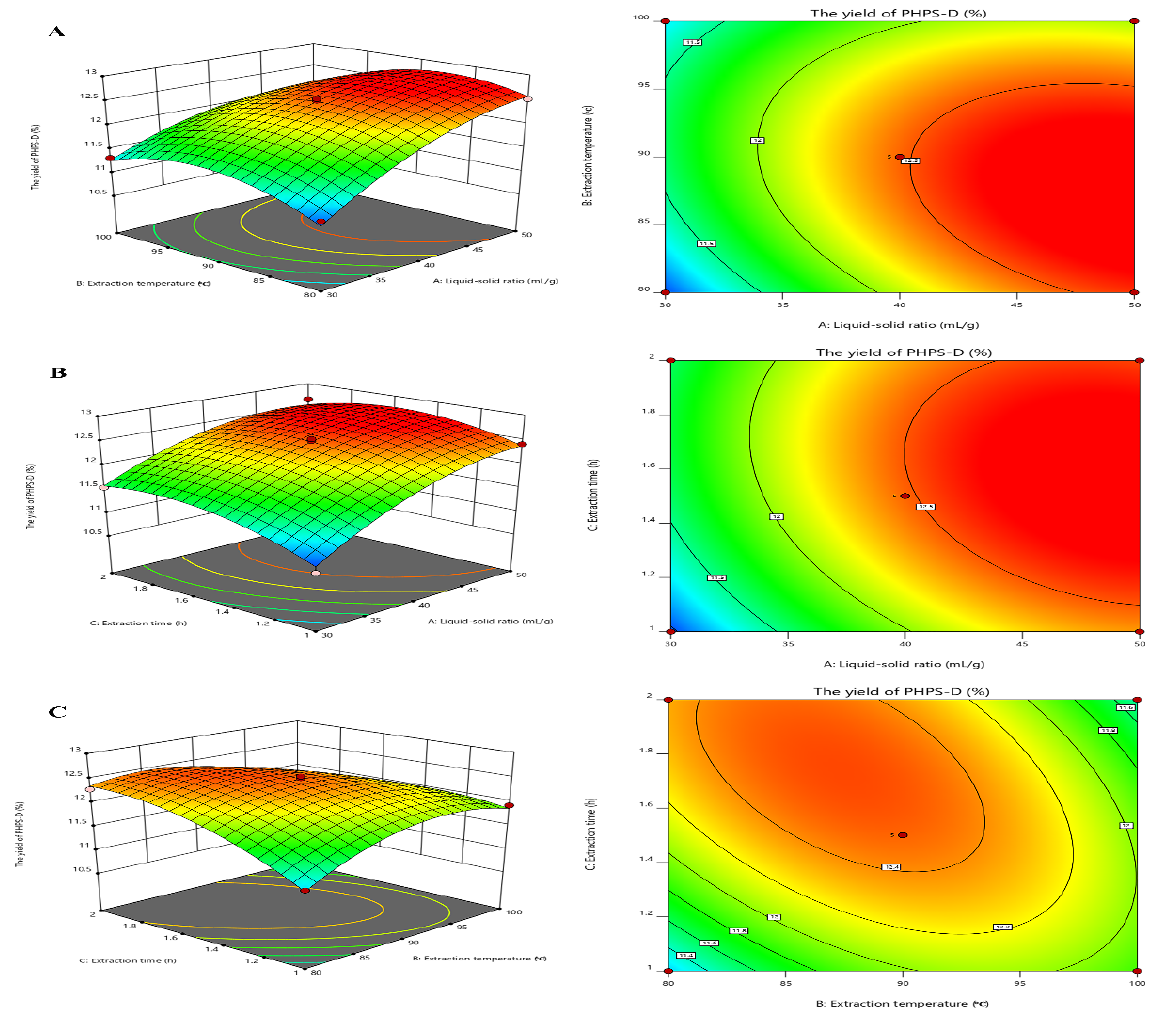
Figure 3. Plots of three-dimensional response surface and two-dimensional contour of the tailorable Chcl-SA-assisted extraction for PHPS-D yield: the interactive effects of liquid to solid ratio and extraction temperature ( A ); the interactive effects of liquid to solid ratio and extraction time ( B ); and the interactive effects of extraction temperature and time ( C ).